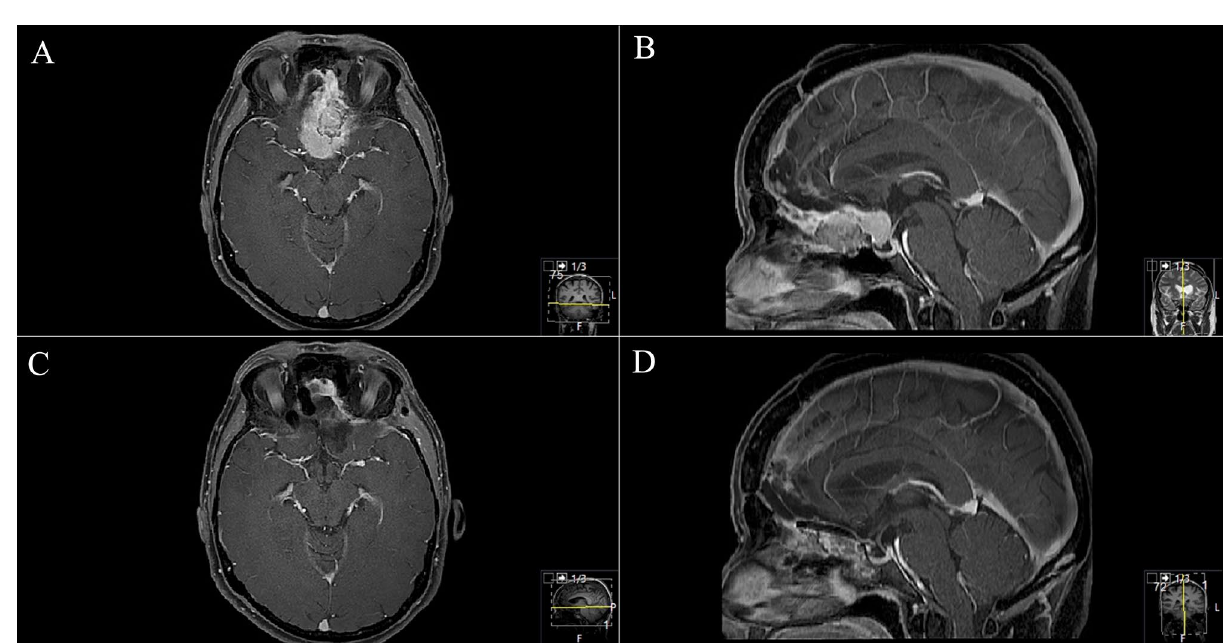
Figure 3. Exemplary case 3: a 60-year-old female patient with left amaurosis and right progressive visual deficit after two-timed resection of transbasal meningotheliomatous meningioma WHO grade I through a bifrontal craniotomy. ( A , B ) Preoperative T1-weighted gadolinium-enhanced MR imaging showing frontobasal meningioma with olfactory grove, ethmoidal and sphenoidal sinus and intrasellar affection. ( C , D ) Postoperative MR control showing Simpson II resection. Extradural clinoidectomy was performed in this case as well. Reconstruction was performed with split-bone graft and galea-periosteum flap. The patient recovered well from the procedure and underwent radiotherapy after multidisciplinary tumor board